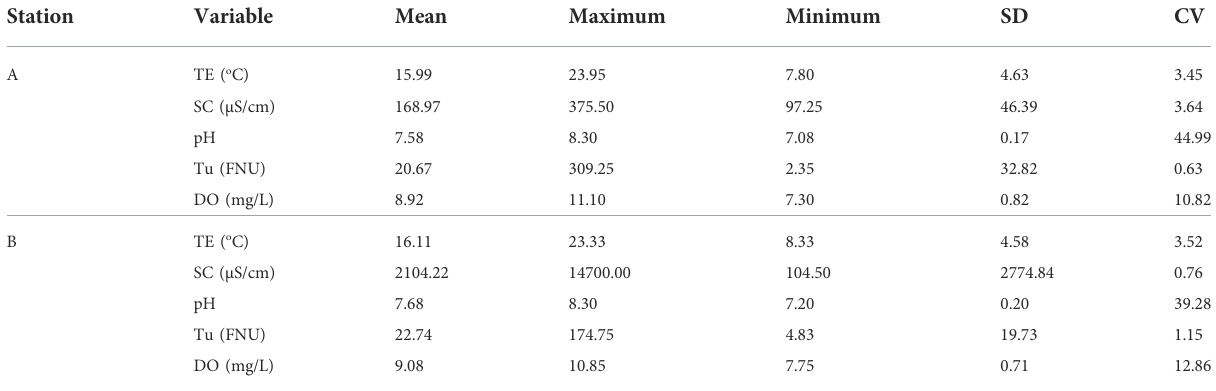
TABLE 1 Statistical description of data sets at study stations.